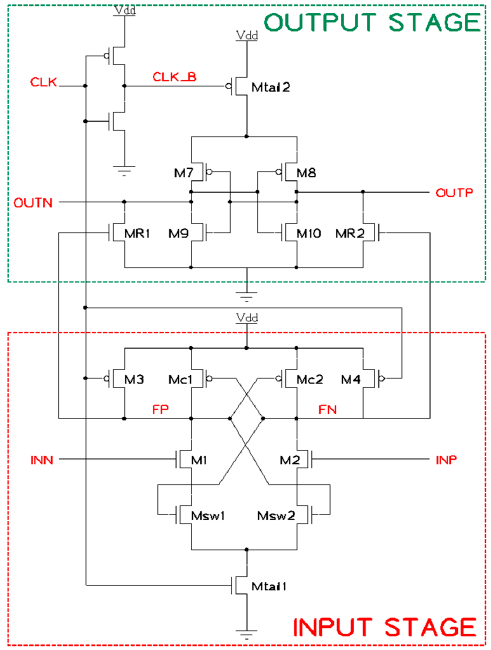
Figure 7. The proposed DT comparator.